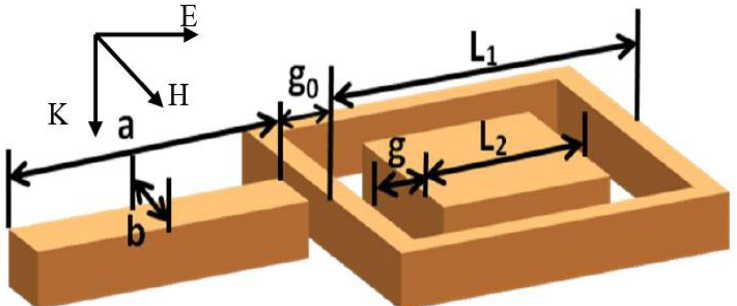
Figure 1. Sketch of the RCSRD and the incident